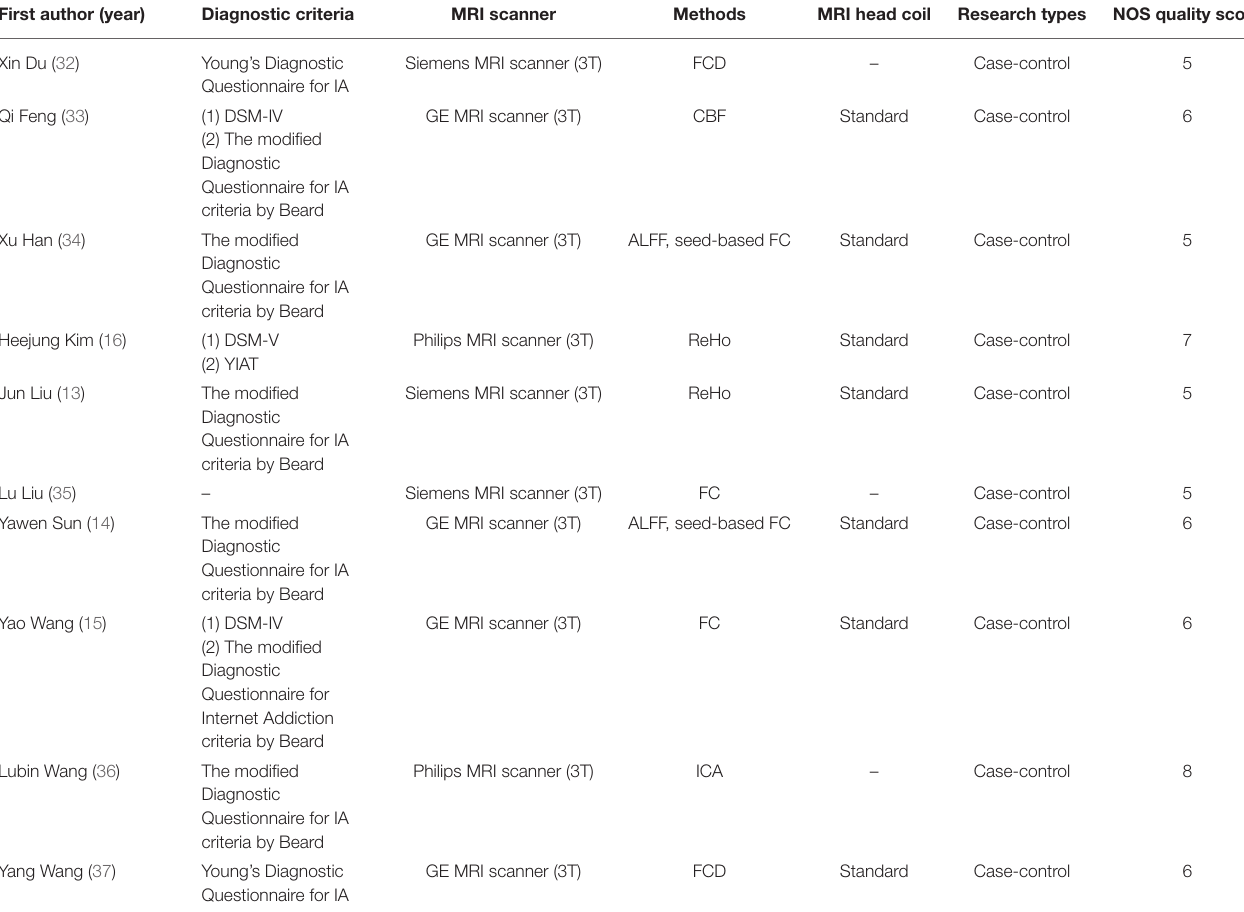
TABLE 2 | Methodological characteristics included in the